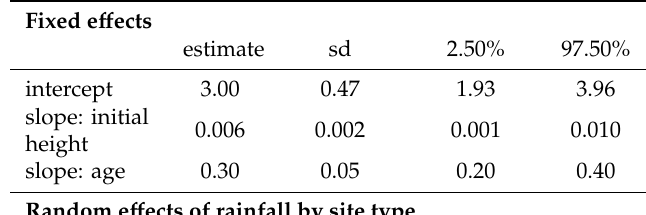
Table 3. Estimated parameters of the lmm model of apical growth (mm) and associated confidence intervals and standard deviation and associated confidence intervals. Age: seedling age in years, initial height in mm, rainfall: May rainfall in